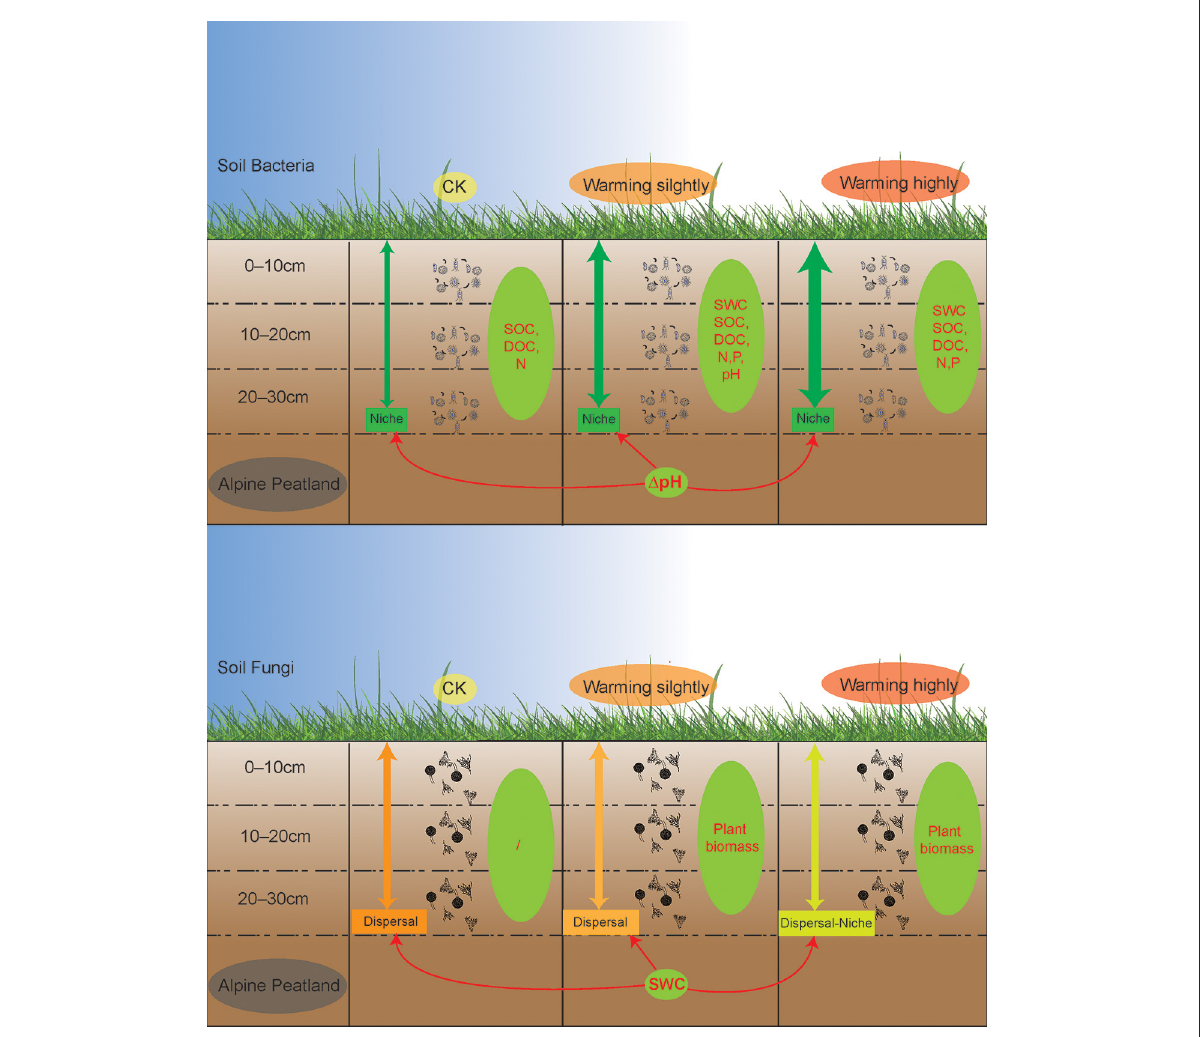
FIGURE6 A schematic plot to show the vertical assembly of soil bacterial and fungal communities’ response to warming in alpine peatland. Thicker green arrows indicate stronger niche processes while darker orange arrows indicate stronger dispersal processes. Green ellipses represent factors driving the vertical structure of the microbial communities, while the red one-way arrows represent factors that influence the vertical assembly of the